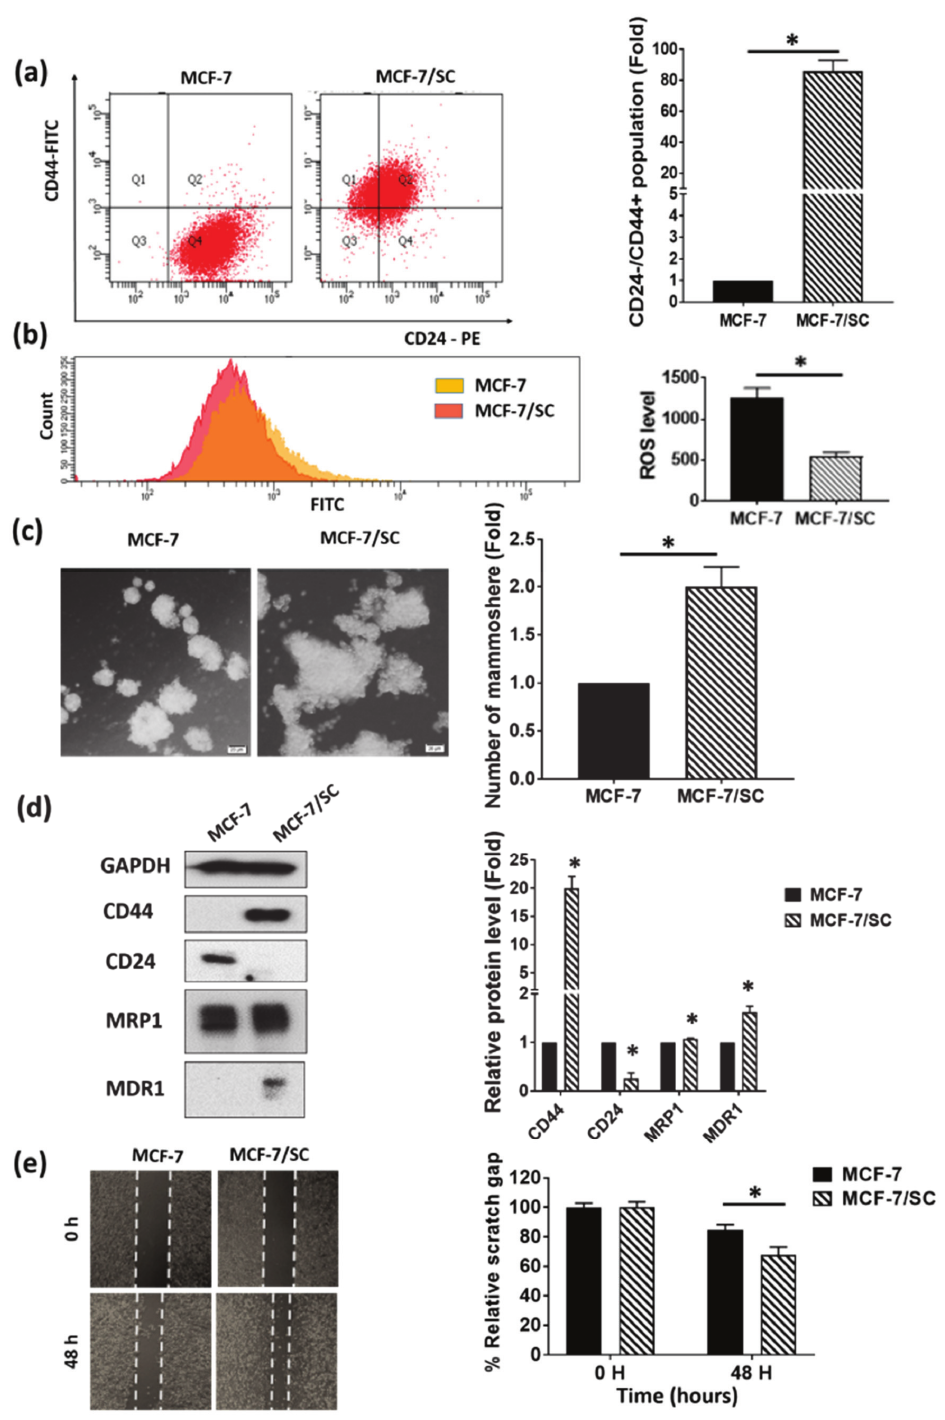
Figure 1. MCF-7 / SC exhibit more prominent cancer stem cell characteristics than the parental MCF-7 cells. ( a ) Fluorescence-activated cell sorting (FACS) analysis of the CD44 + / CD24 − cell population in MCF-7 / SC and MCF-7 cells. ( b ) Measurement of the ROS levels in MCF-7 / SC and MCF-7 cells. ( c ) Comparison of the mammosphere formation ability of MCF-7 / SC and MCF-7 cells cultured in the MammoCult Human Medium for 10 days. Magnification 100 × . ( d ) Analysis of the expression of cancer stem cell markers in MCF-7 / SC and MCF-7 cells by Western blotting. GAPDH was used as a loading control. ( e ) Migratory potential of MCF-7 / SC and MCF-7 cells as assessed by the wound healing assay. Data are shown as the mean ± standard deviation of three biologically independent experiments. * p < 0.05 vs.